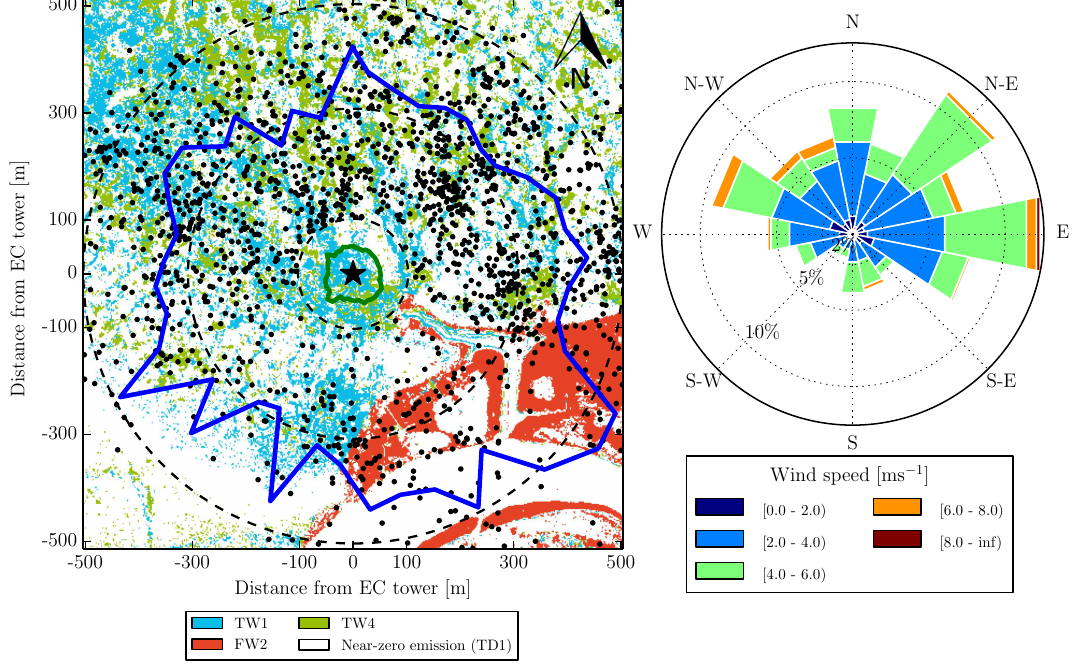
Figure 5. Flux footprint climatology of the EC methane measurement periods (left) and wind rose (right). Blue contour line shows average 80% cumulative flux distance and dark green contour line shows average location of the footprint function peak value for both EC methane measurement periods binned by wind direction. Black dots show the half-hourly 80% cumulative flux distances. Location of the EC tower is marked with a black star. Dashed concentric circles show the 100, 300 and 500m distances to the EC tower. The underlying image shows spatial distribution of the vegetation classes for which methane fluxes were modelled. The wind rose shows the distribution of winds during 2008 and 2009 measurement